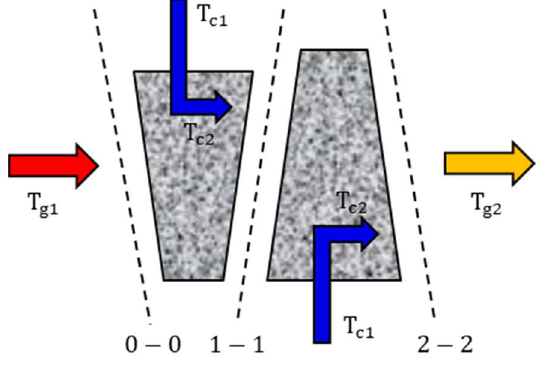
Figure 5. Schematic diagram of an element stage.